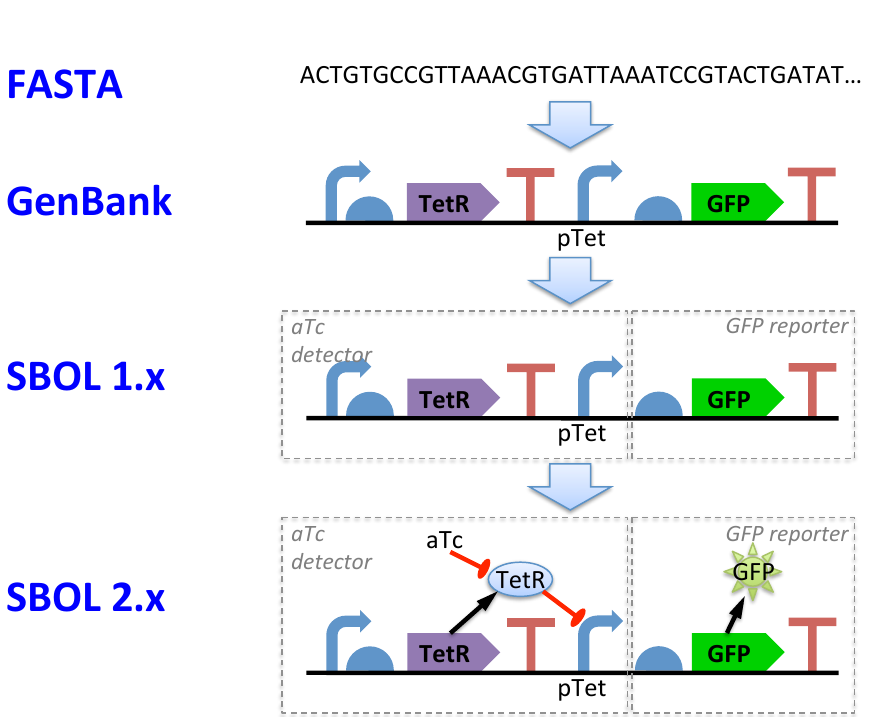
Figure 1: SBOL 2 extends prior sequence description formats to represent both the structure and function of a genetic design in a modular, hierarchical manner.